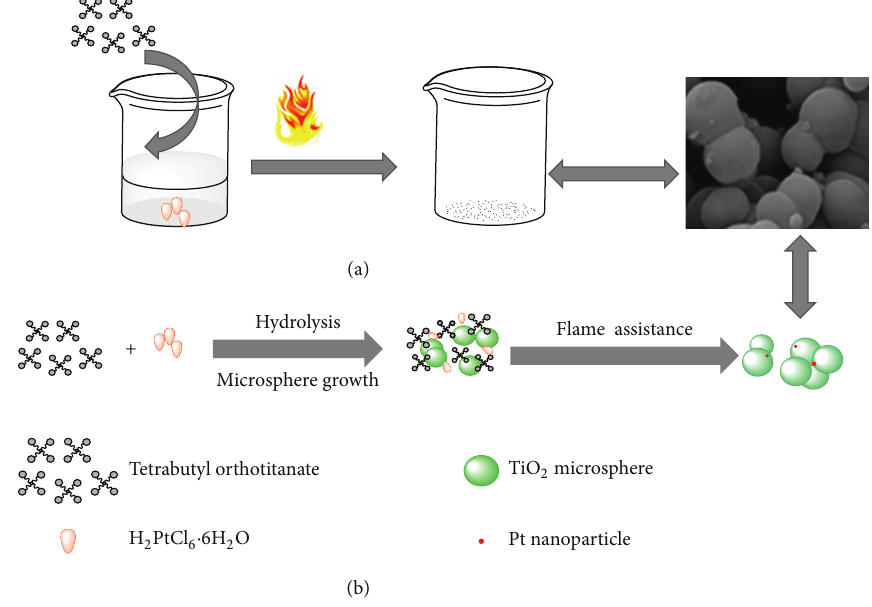
Scheme 1: (a) Schematic illustration of the fabrication procedure of Pt-C/TiO 2 composite. (b) Schematic representation of Pt-C/TiO 2 microsphere growth